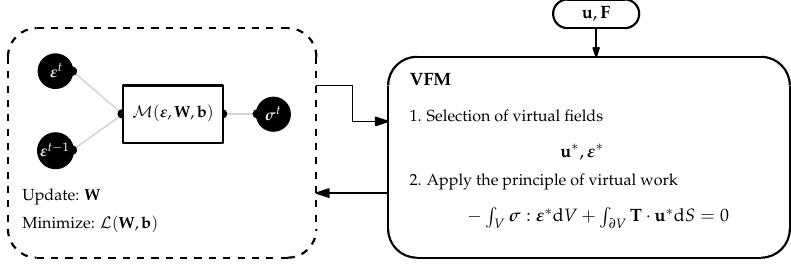
Figure 7. Coupled ANN-VFM method for implicit constitutive